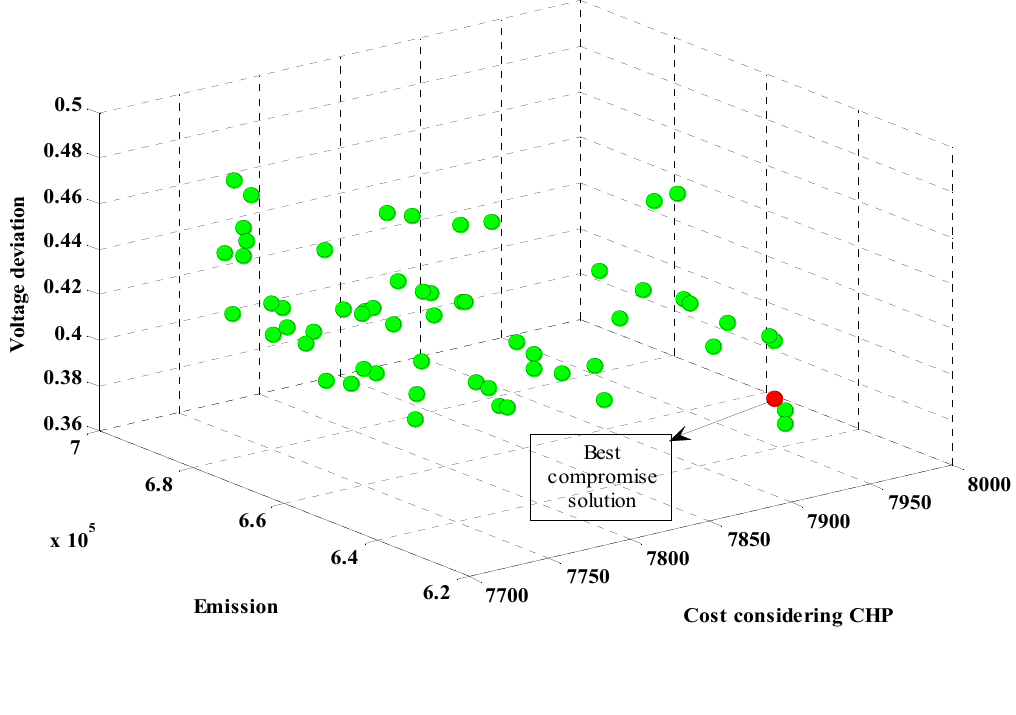
Figure 11. Pareto front for cost considering strategy 2, emission and voltage deviation objective